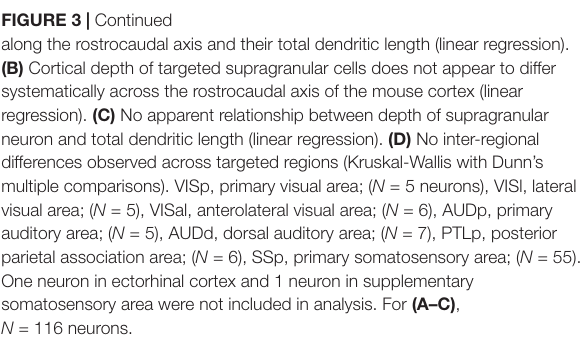
FIGURE 3 | Continued along the rostrocaudal axis and their total dendritic length (linear regression). (B) Cortical depth of targeted supragranular cells does not appear to differ systematically across the rostrocaudal axis of the mouse cortex